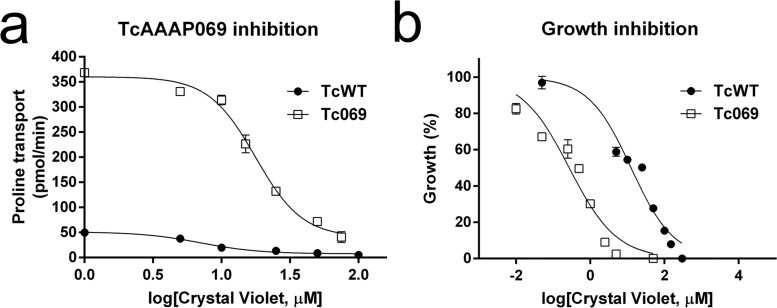
Validation of crystal violet as proline transporter TcAAAP069 inhibitor.(a) Inhibition of proline transport in wild type parasites (TcWT, black circles) and parasites overexpressing TcAAAP069 (Tc069, white squares). (b) Trypanocidal effect of crystal violet in TcWT (black circles) and Tc069 (white squares) parasites. The data is expressed as the mean ± standard deviation and corresponds to three independent experiments.